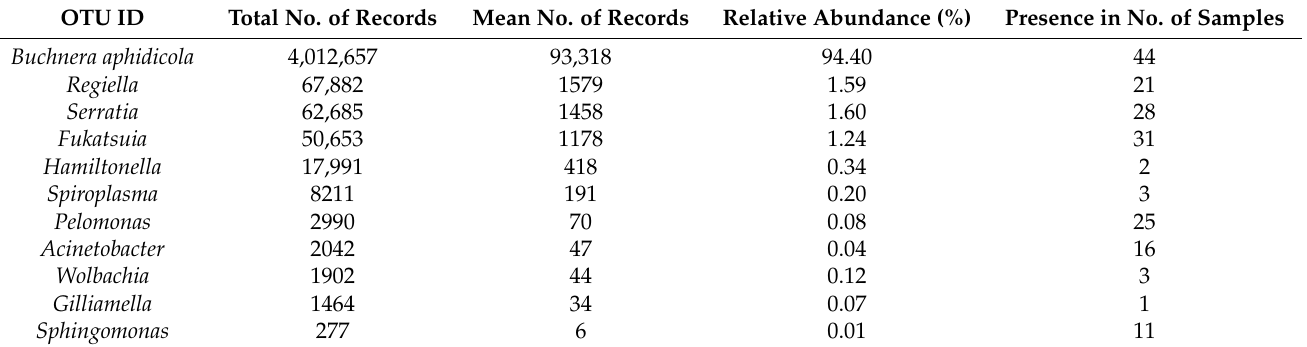
Table 1. Records of symbiont species in the studied